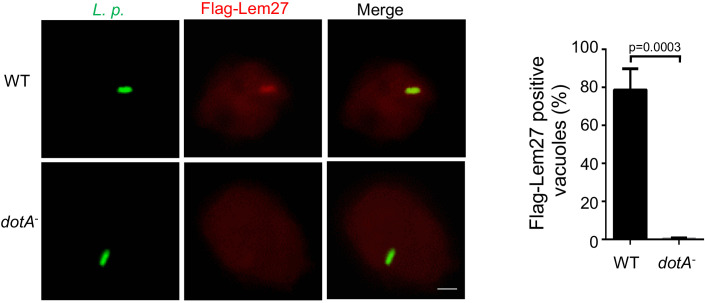
The association of Lem27 with L. pneumophila phagosomes in D. discoideum D. discoideum cells seeded on coverslips were infected with wild-type L. pneumophila or the dotA mutant expressing.Flag-Lem27 for 2 hr. Samples were fixed and subjected to immunostaining to identify the LCVs and Flag-Lem27. Samples were analyzed by visual inspection under a fluorescence microscope to acquire representative images of the LCV positive or negative for Flag-Lem27 (left panel) and to determine the rates of vacuoles stained positive for the protein (right panel) by counting at least 150 phagosomes each sample. Data shown were from three independent experiments. Bar: 2 μm.